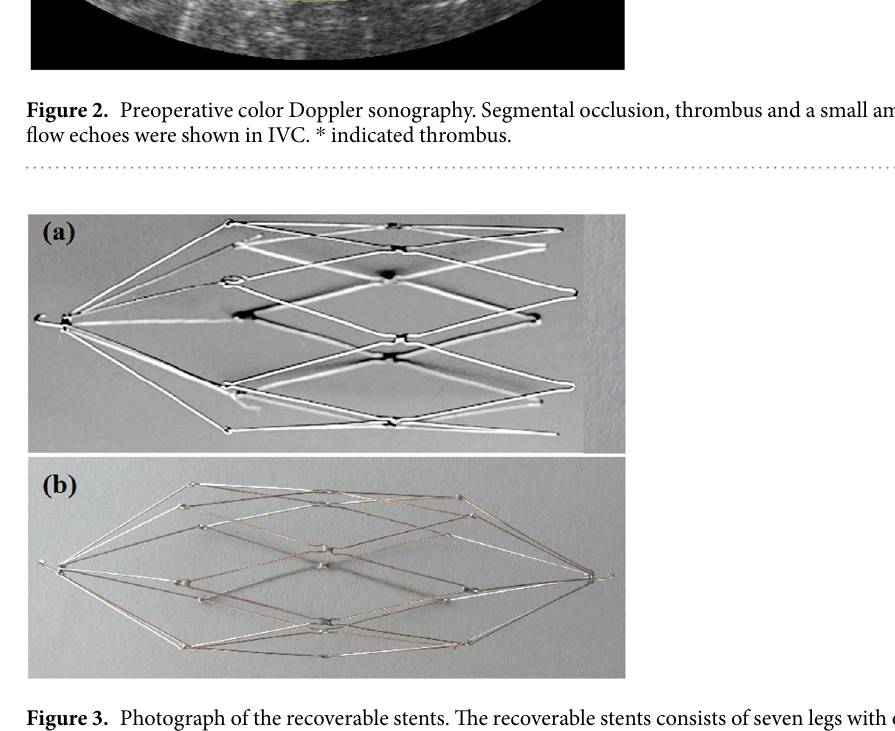
Figure 3. Photograph of the recoverable stents. The recoverable stents consists of seven legs with one ( a ) or two ( b ) retrieval hooks at the apex of the cone